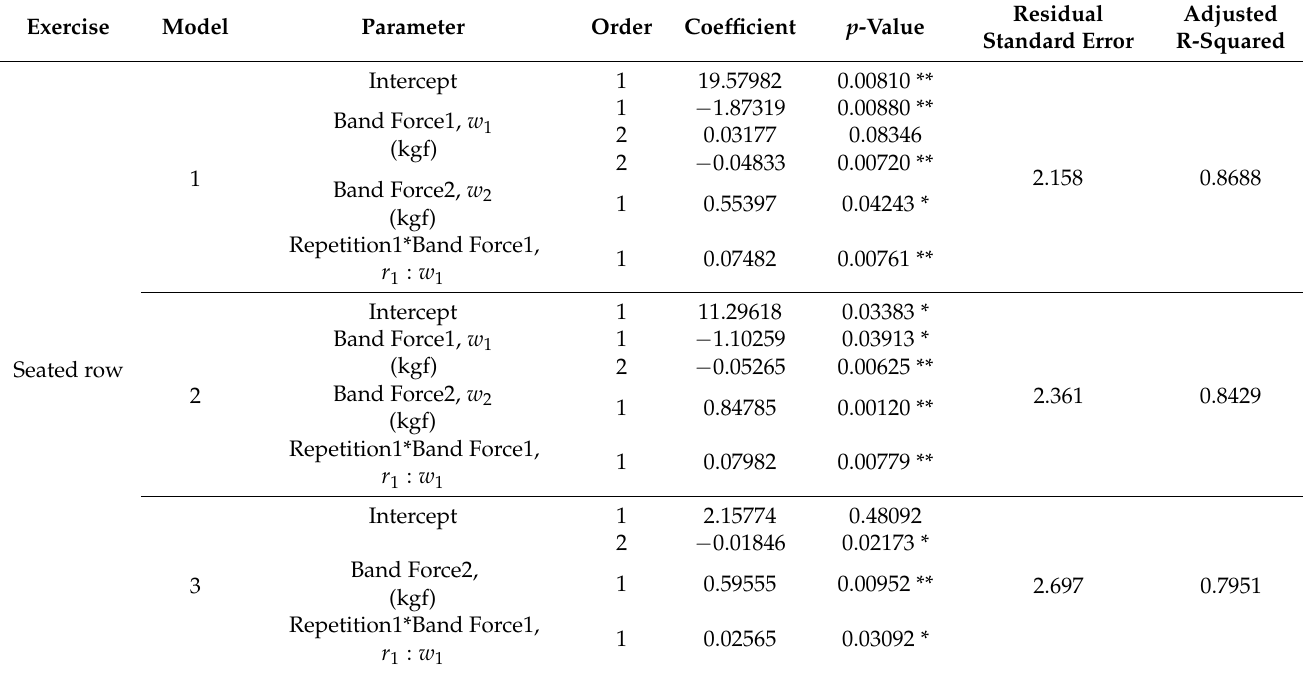
Table A3. Seated row 1 − RM equations and model reduction.